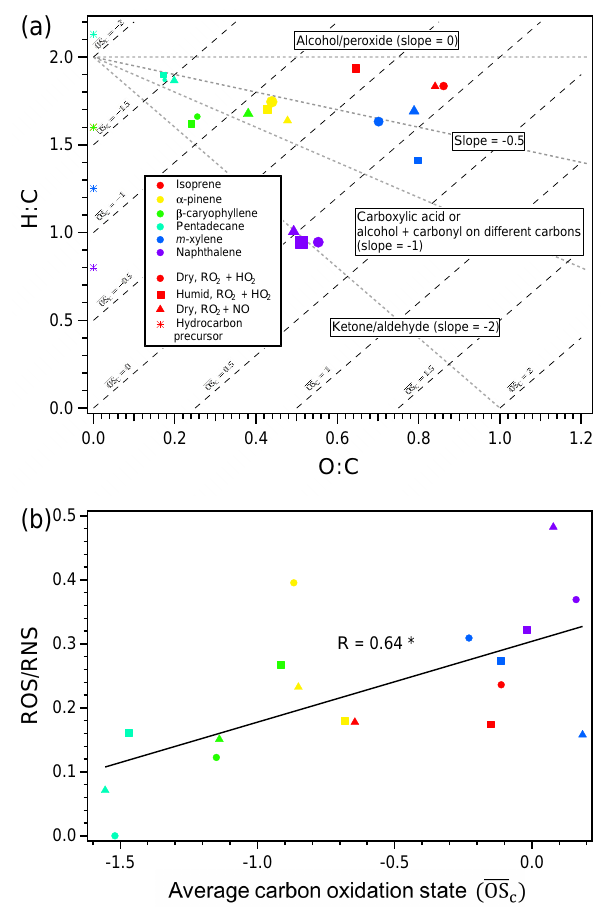
Figure 3. Van Krevelen plot for various SOA systems sized by ROS/RNS levels (a) and correlation between ROS/RNS levels and average carbon oxidation state (b) . Data points are colored by the SOA system (red: isoprene, yellow: α -pinene, green: β - caryophyllene, light blue: pentadecane, blue: m -xylene, and pur- ple: naphthalene), shaped according to formation conditions (cir- cle: dry, RO 2 + HO 2 ; square: humid, RO 2 + HO 2 ; and triangle: dry, RO 2 + NO). SOA precursors are shown as stars, colored by the SOA system. ∗ indicates significance, p <